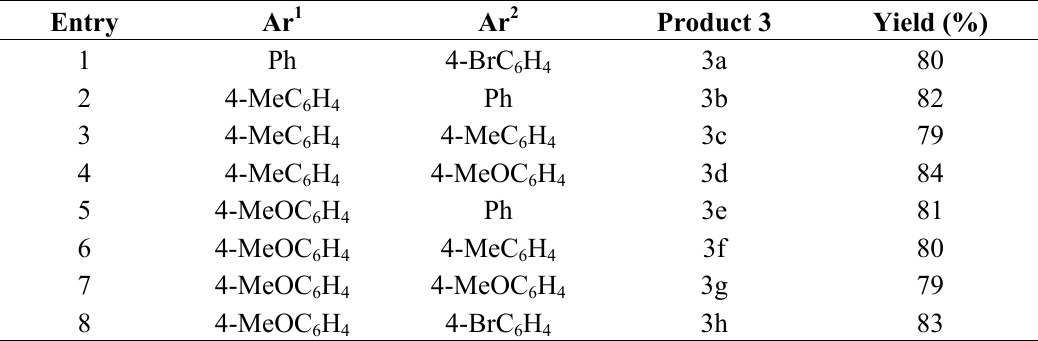
Table 1. Synthesis of spiro[indeno[1,2-b]pyrrole-3,2'-pyrroles] 3 .